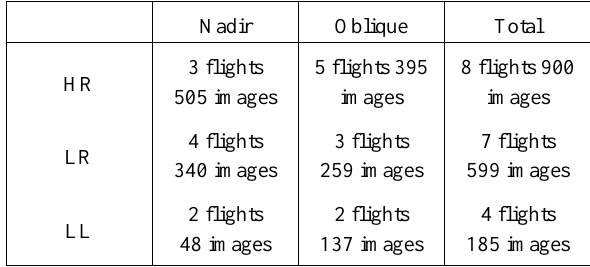
Table 2. UAV photogrammetric data.